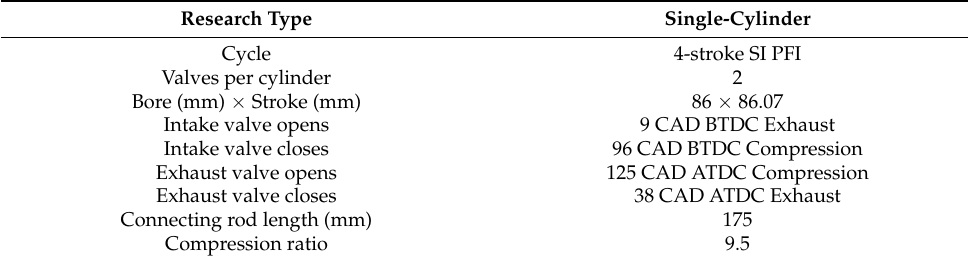
Figure 1. A 1D CFD model of a spark-ignition engine. Table 2. The parameters of the research engine.